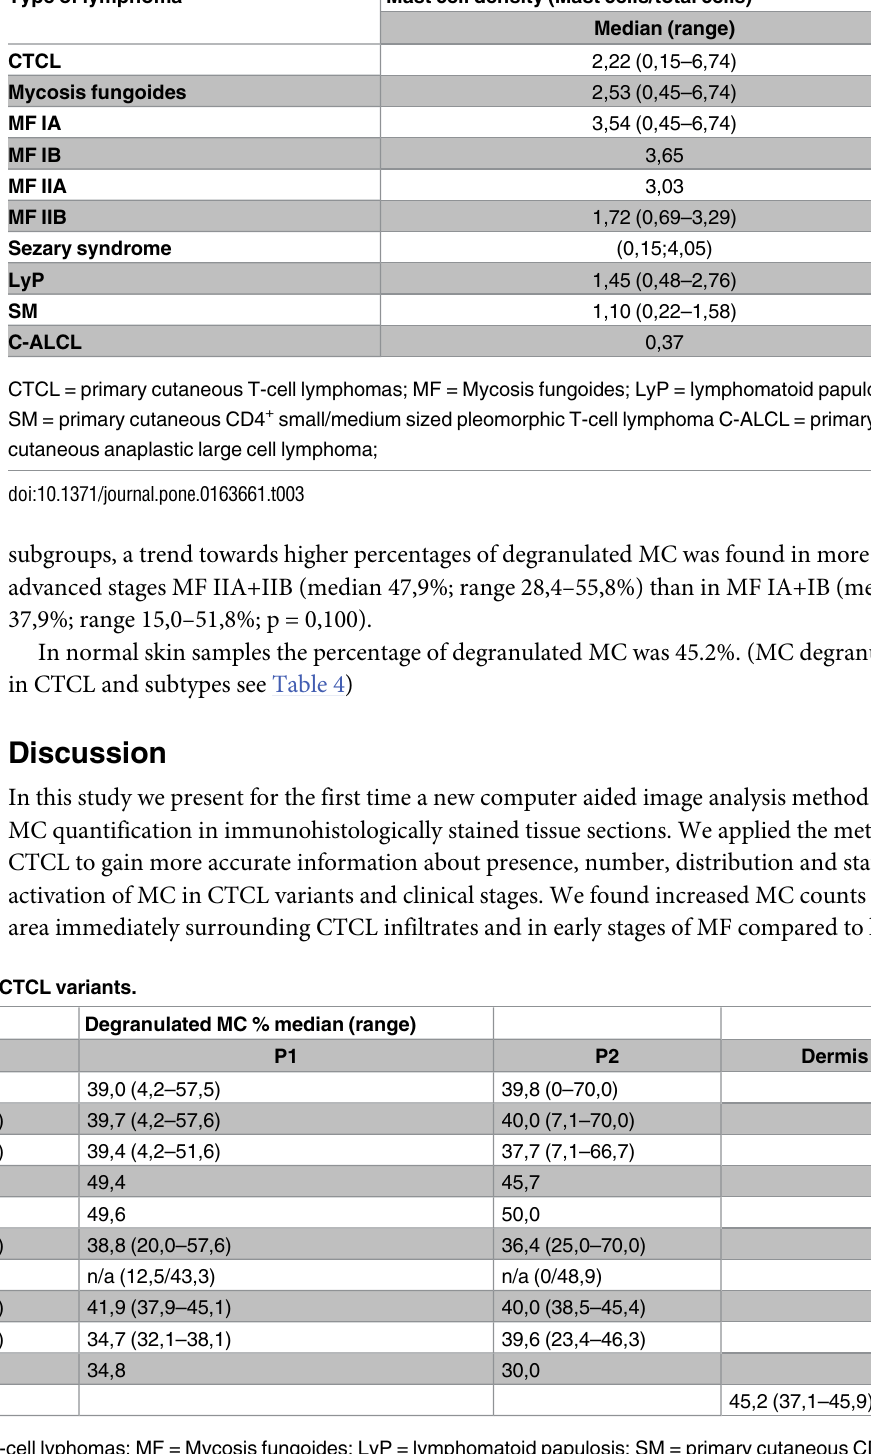
Table 3. Mast cell density in relation to tumor cell density in CTCL variants.